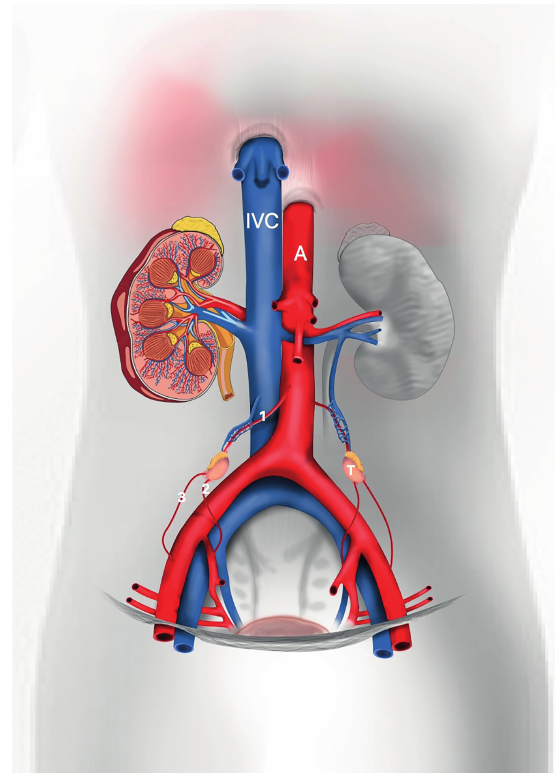
Figure 2 - Schematic drawing showing the testicular vascularization during the human fetal period. We can observe the testis situated in abdominal position and the three arteries that irrigated the gonad, 1- testicular artery, 2- vassal artery, 3- cremasteric artery, A- Aorta artery and IVC- Inferior vena cava.